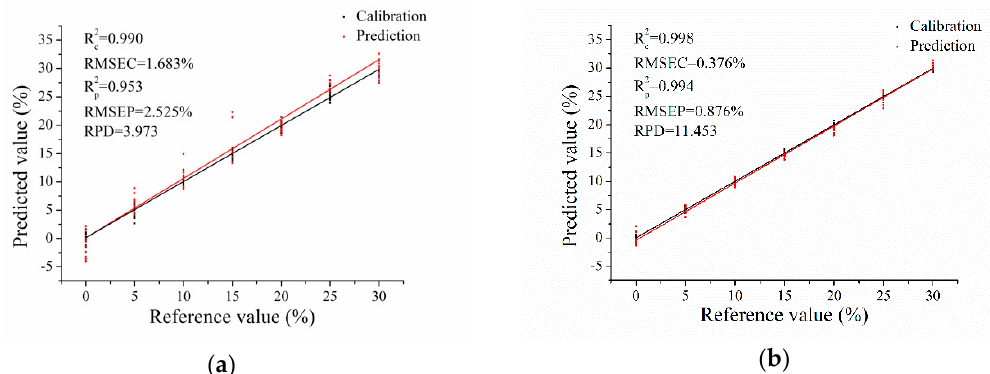
Figure 4. The plots of the prediction value versus the reference value of ELM models using the selected optimal wavenumbers for ( a ) Milk adulterated with rice flour; ( b ) Milk adulterated with soybean flour. Table 7. Results of determination of adulterations content in milk using optimal wavenumbers.